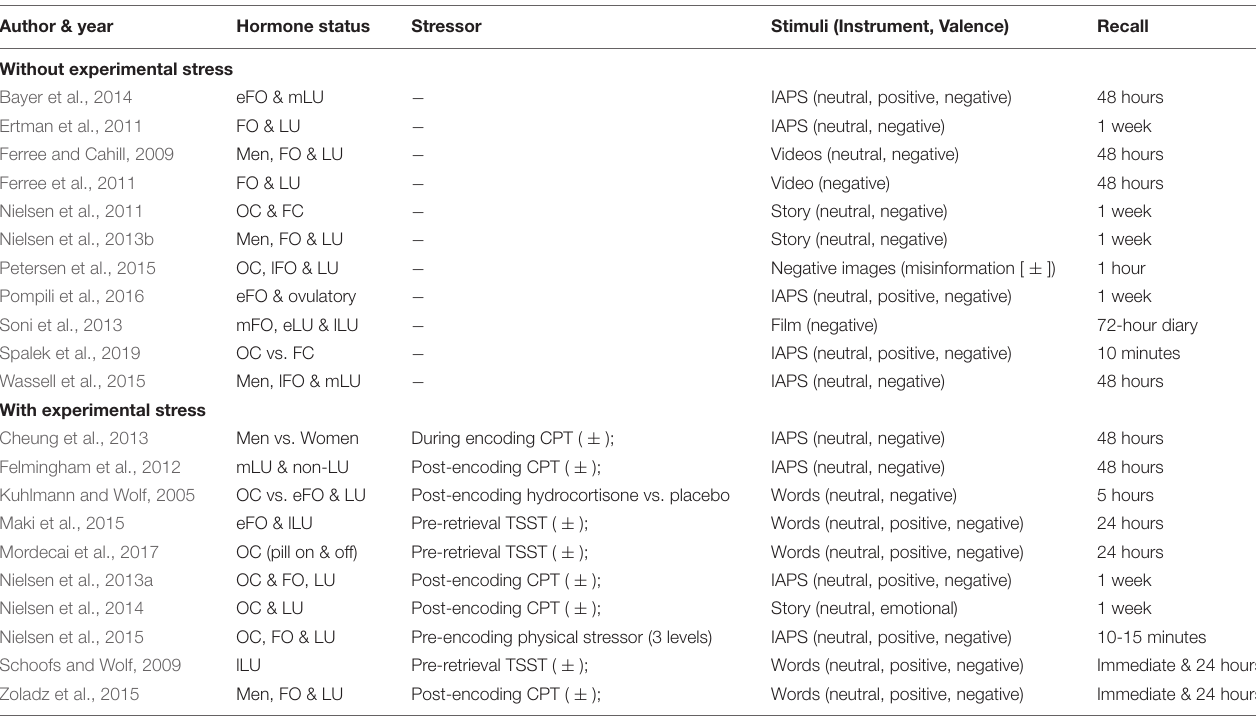
TABLE 4 | Emotional memory, ovarian hormones, and stress: Operationalization of the factors hormone status and stimuli (instrument and valence), and specification of the recall